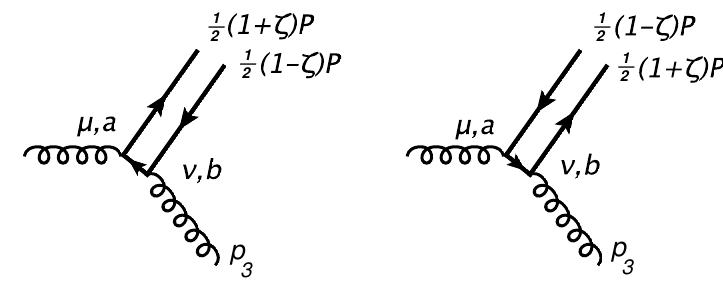
Figure 3 . Feynman diagrams for the tensor amplitude T (cid:22)(cid:23) for g (cid:3) ! t (cid:22) t + g at LO. The hard form factor for g (cid:3) ! t (cid:22) t + g can be obtained by contracting the tensor T (cid:22)(cid:23) 1 V